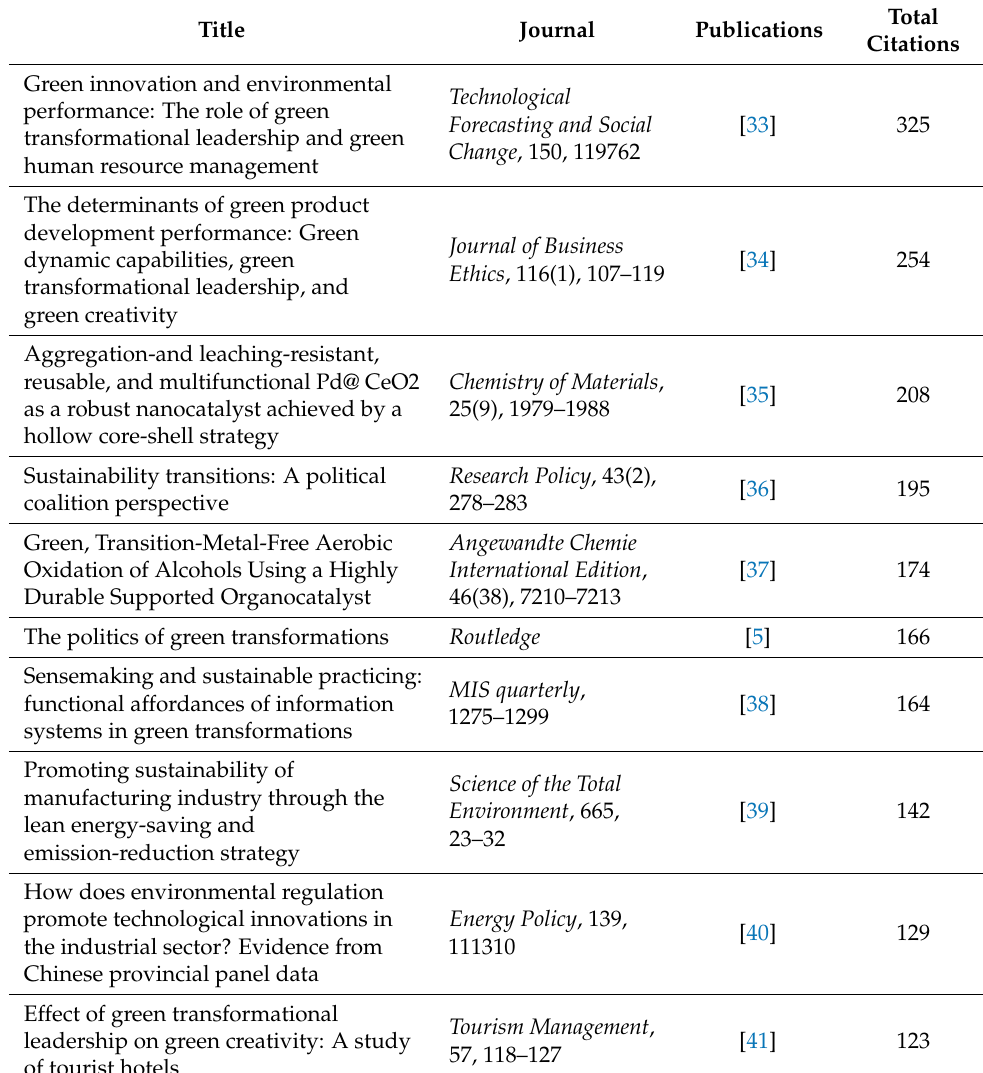
Table 3. The top ten most cited